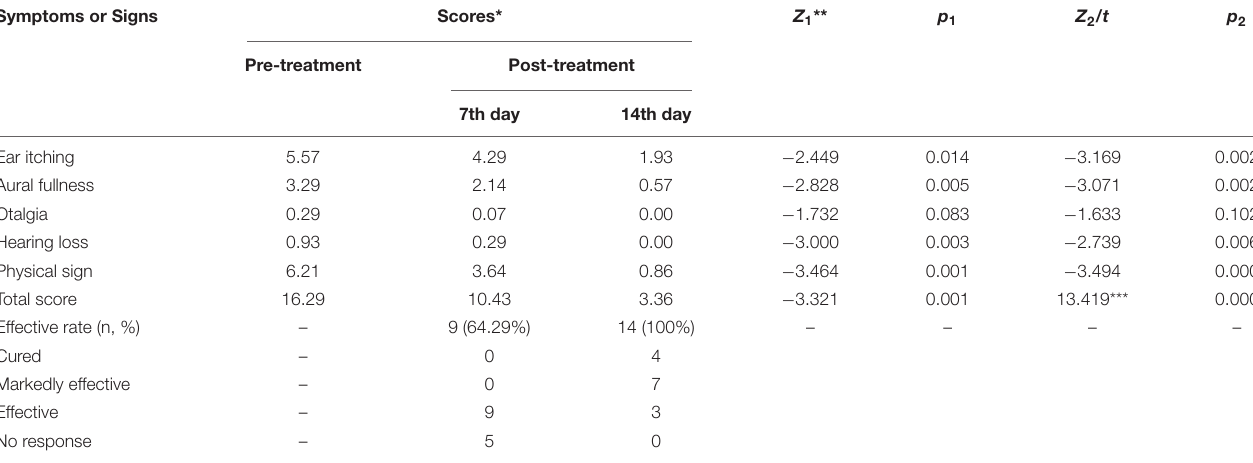
TABLE 2 | Comparison of symptom and sign scores, effective rates in the pre- and post-treatment